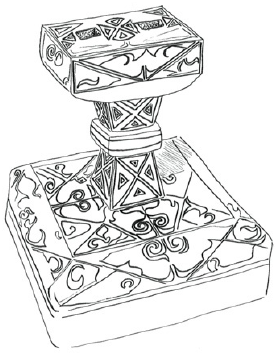
Figure 11. Line drawing of lacquered wood antler stand from Tomb 1 at Changtaiguan, Xinyang, Henan. Adapted from Henan sheng wenwu yanjiusuo (1986, pl. 70.1) courtesy of Zay Olsen. The Changtaiguan stands were individually decorated with black and red